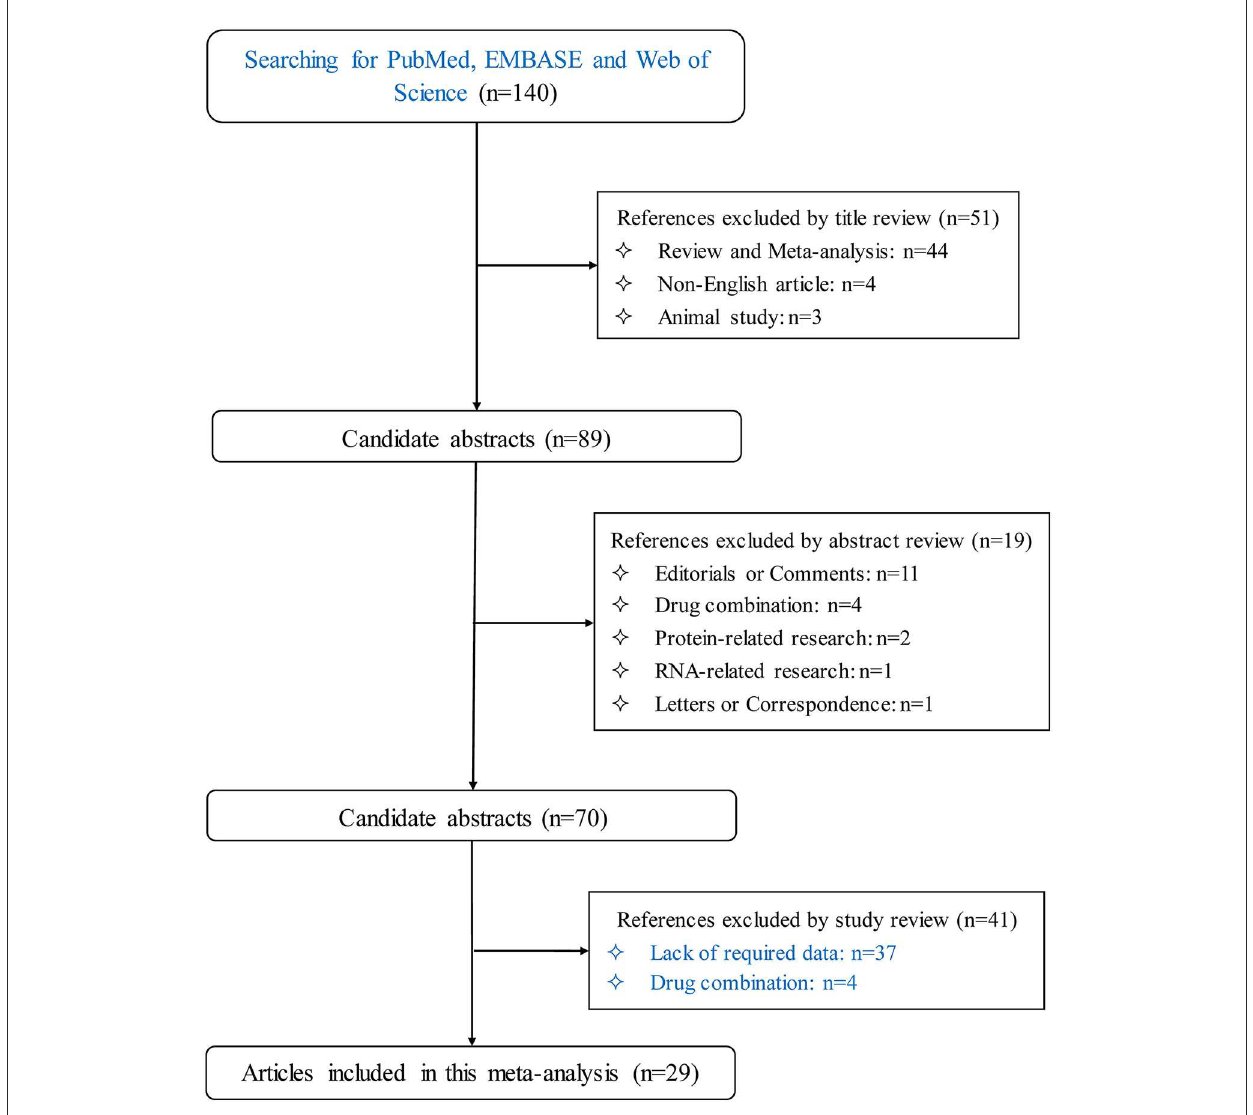
FIGURE1 PRISMA flowchart illustrates the selection process of qualified articles with specific reasons for exclusion in this